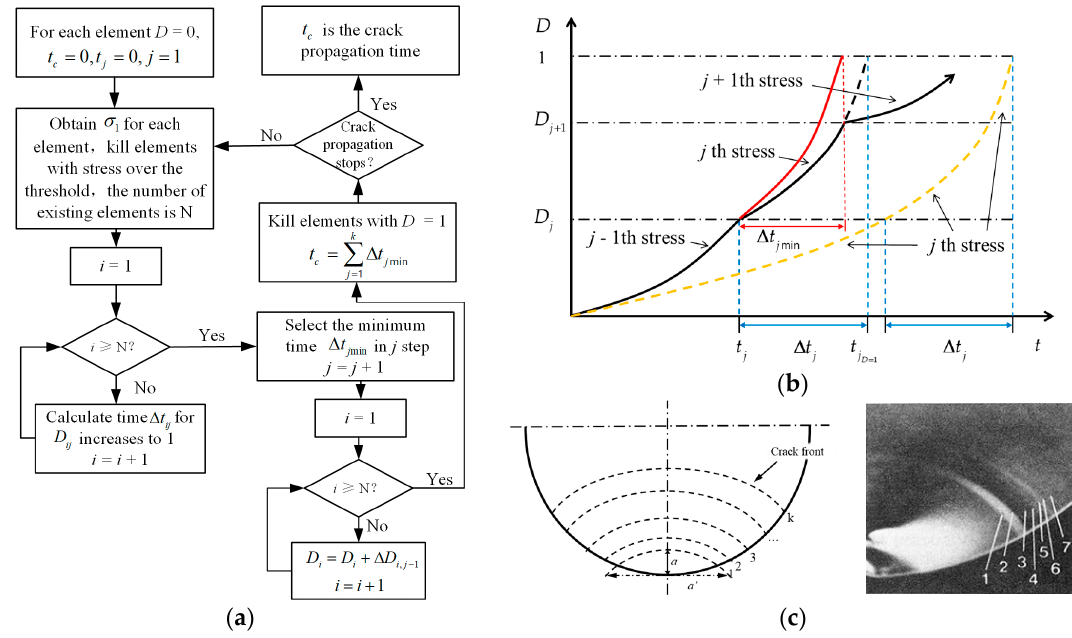
Figure 4. The calculation procedure for the crack propagation time and morphologies of the crack propagation states: ( a ) calculation procedure of the damage values and the crack propagation times; ( b ) computational procedure of the accumulated damage; ( c ) diagrammatic sketch and micrograph of the different crack propagation states.